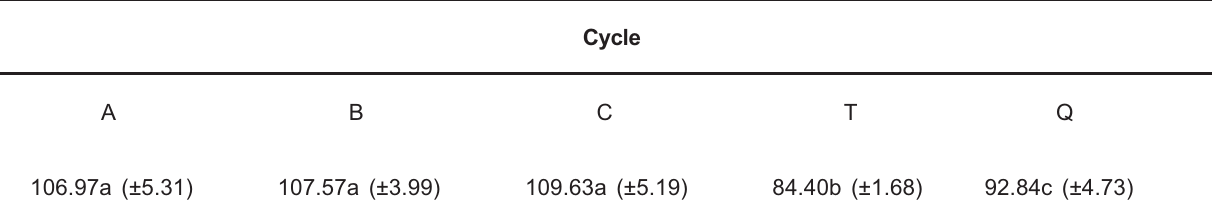
*Different letters indicate statistically significant difference at